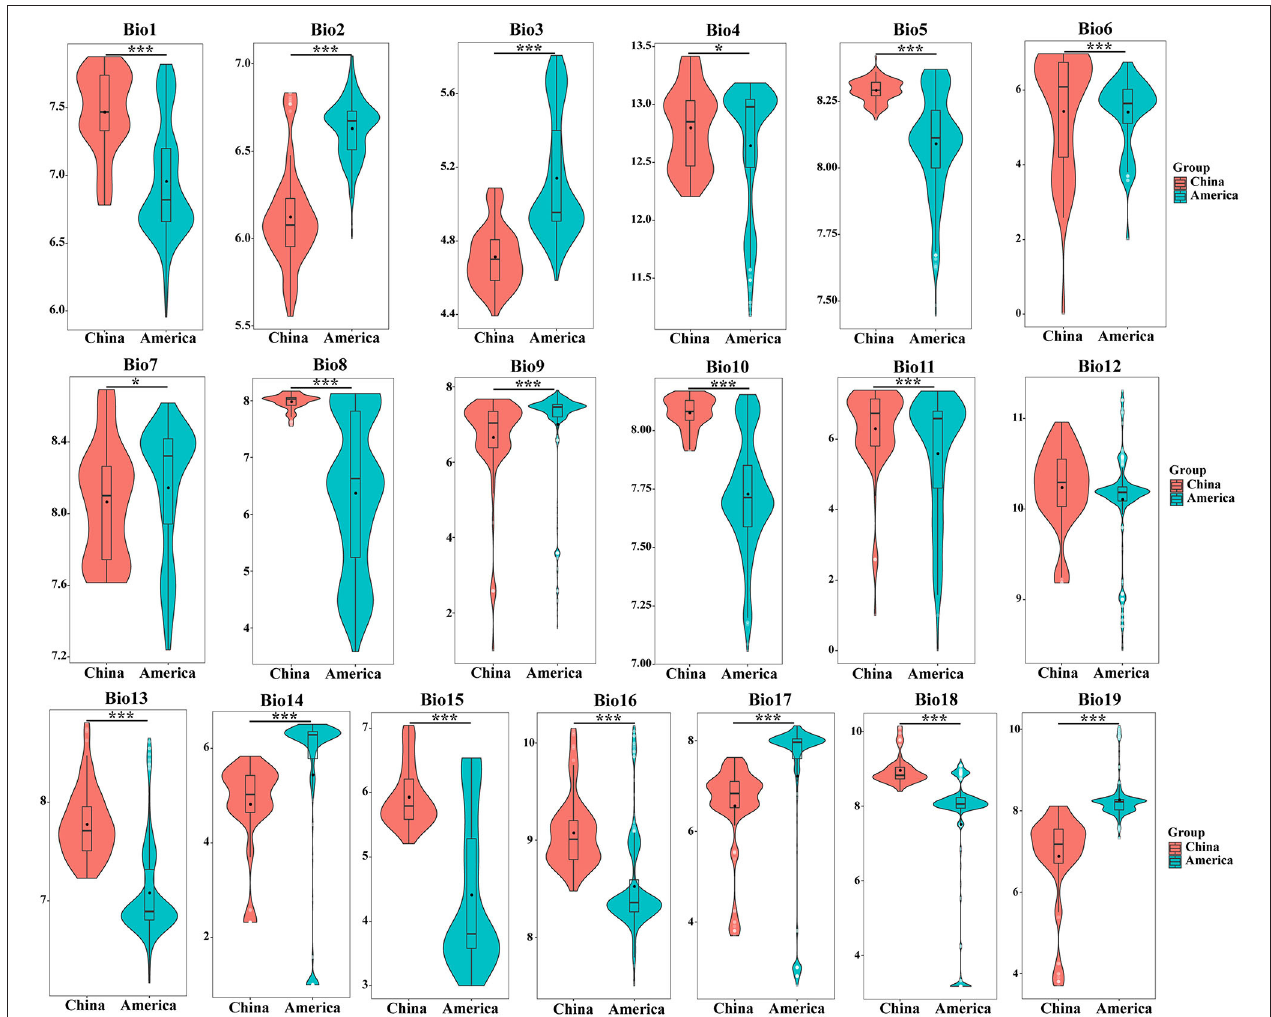
FIGURE 2 | The comparison of S. alterniflora environmental variables between origin and invasion countries. The asterisk shows the level of significance between environmental variables in China and America. * means P < 0.05, ** means P < 0.01, *** means P <